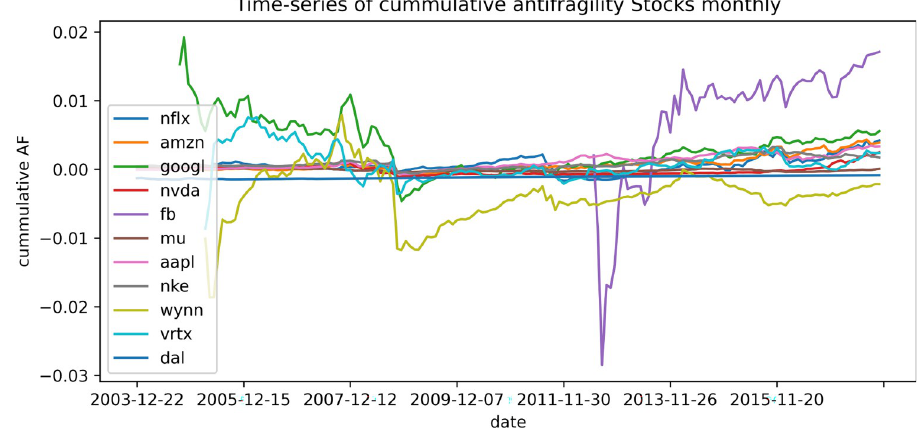
Fig 13. Cumulative mean of antifragility of few assets. The x- axes shows the date and the y- axis the cumulative antifragility measure. The figure shows the cumulative monthly antifragility of selected ‘top-performing’ stocks.